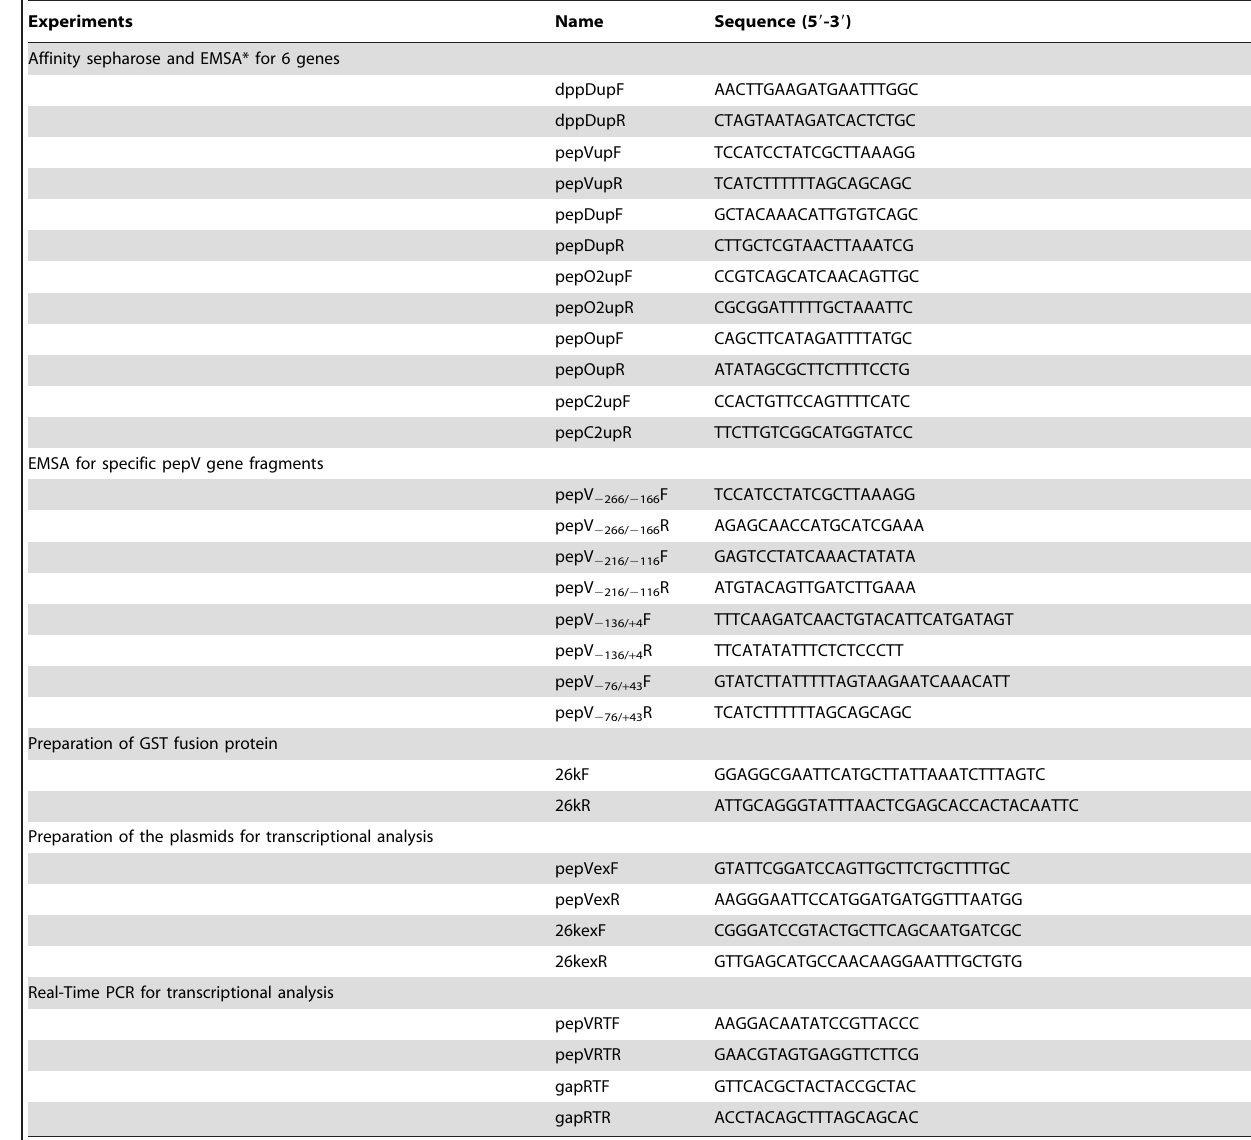
Table 1. Primers used in this